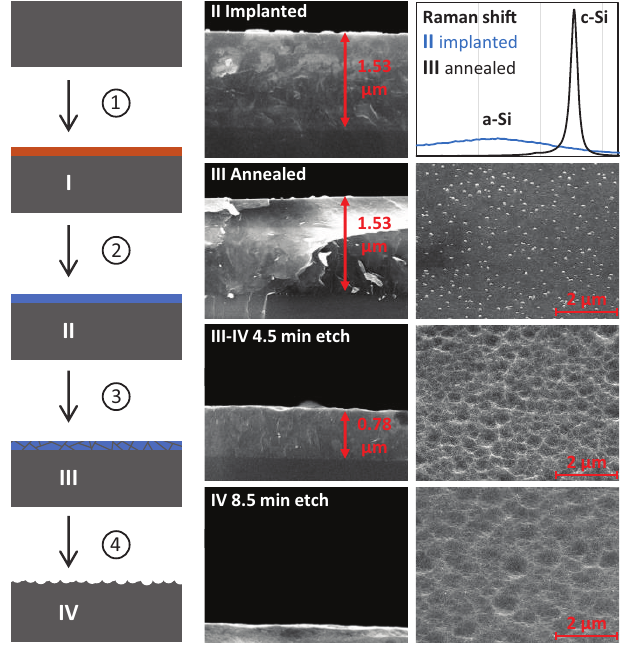
Fig. 1. Flowchart of the sacri fi cial-layer texturing approach ( T sac ). A schematic representation of the sacri fi cial layer and silicon surface at each phase (phase I – IV) is presented on the left. Processing steps 1 – 4 are referenced in the text. A cross-sectional SEM image of the silicon surface and sacri fi cial layer at phase II is presented in the centre, following implantation in an approxi- mately 1.5 m m a-Si layer. Raman spectroscopy measurements of the sacri fi cial layer at phase II and phase III are presented in the top right plot, where the peak referred to as c-Si is positioned at images of the cross-section and surface of the substrates at a 40 ° tilt, at phase III and IV and at some point between these phases are presented as